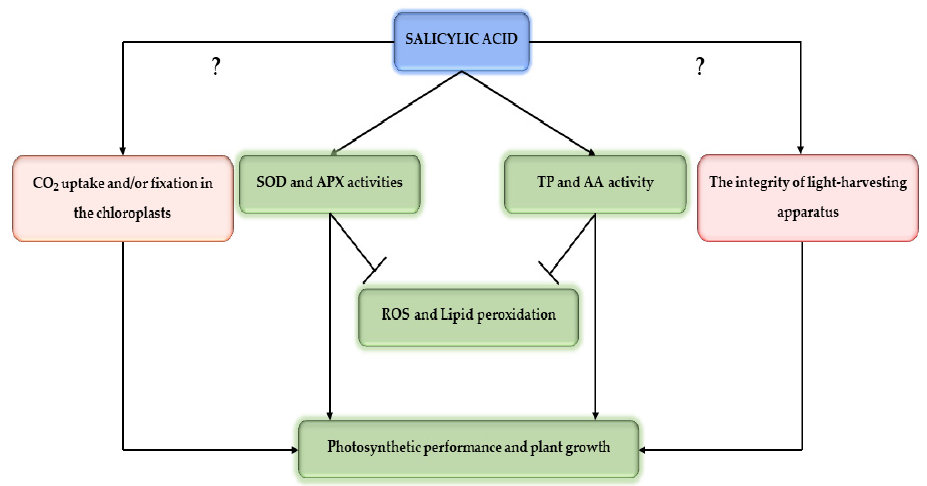
Figure 6. Schematic representation of SA-induced mechanism to tolerate drought stress in A. chilensis plants. We suggested that SA induces enzymatic and non-enzymatic antioxidant mechanisms to tolerate drought stress, decrease oxidative stress, and improve photosynthesis performance and plant growth in A. chilensis plants. Abbreviations: superoxide dismutase (SOD), ascorbate peroxidase (APX), total phenolic content (TPC), antioxidant capacity (AC), reactive oxygen species (ROS).